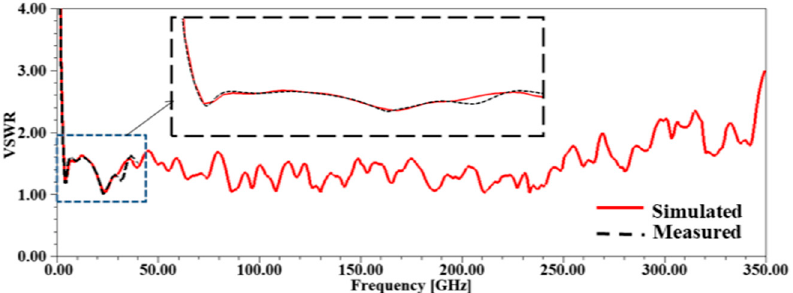
Figure 13. Simulated and measured VSWR of the proposed SWB monopole antenna.